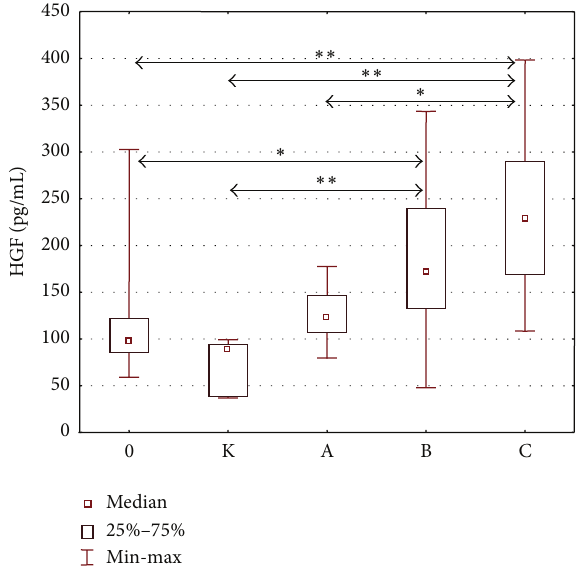
Figure 1: HGF concentration (pg/mL) in the serum of alcoholics without liver cirrhosis (0), alcoholics with liver cirrhosis (stages A, B, and C), and healthy controls (K). Key: ∗ 𝑝 < 0.05 and ∗∗ 𝑝 < 0.001